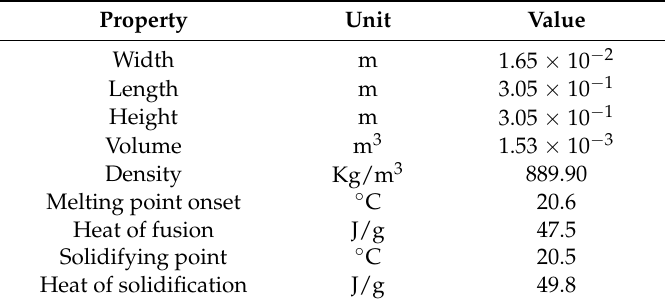
Table 1. Properties of wood-based PCM panels [54,55].